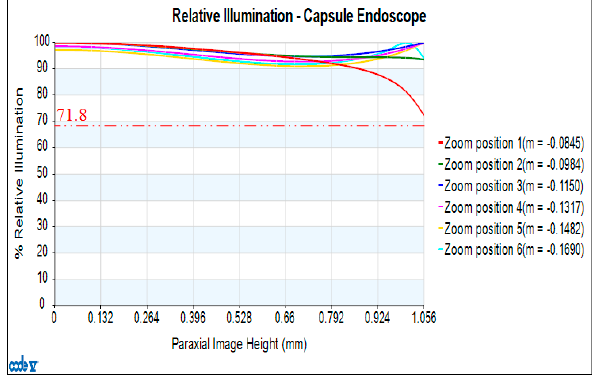
Figure 7. Relative illuminance diagram of a 2× zoom lens.